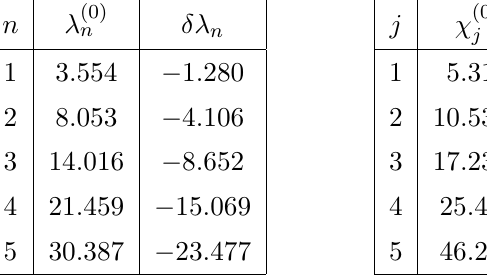
Table 2 . On the left, a table of numerical values for the eigenvalues λ (0) n in the unperturbed background as well as the correction terms δλ . These are related to the mass of the vector glueball n as m 2 = ( λ + δλ ) M 2 . On the right, a table of numerical values for the unperturbed eigenvalues KK corresponding to the scalar meson, as well as the corrections terms: δχ due to the mixing, χ (0) j, 1 j and δχ due to the perturbed background, and δχ = δχ + δχ j, 2 j j, 1 j, 2